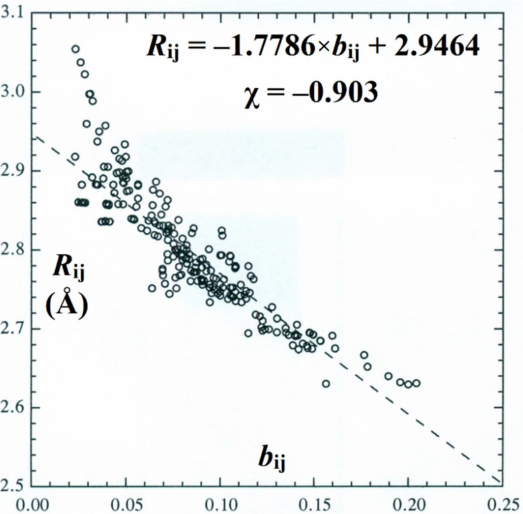
Figure 10. Scatter plot, least-squares regression line, and Pearson correlation coefficient ( χ ) for b ij - R ij BOBL correlations of all (~250) H-bonds in the clusters of Figures 2 and